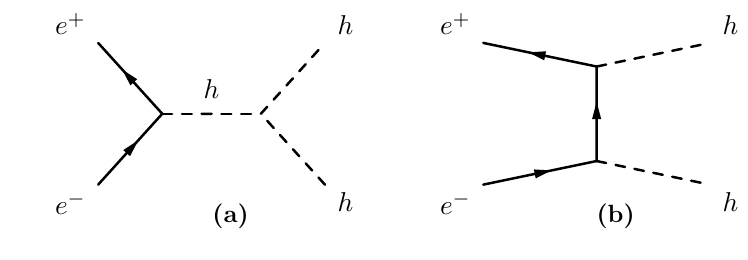
Figure 1. SM tree level diagrams for e + e (cid:0) ! hh .